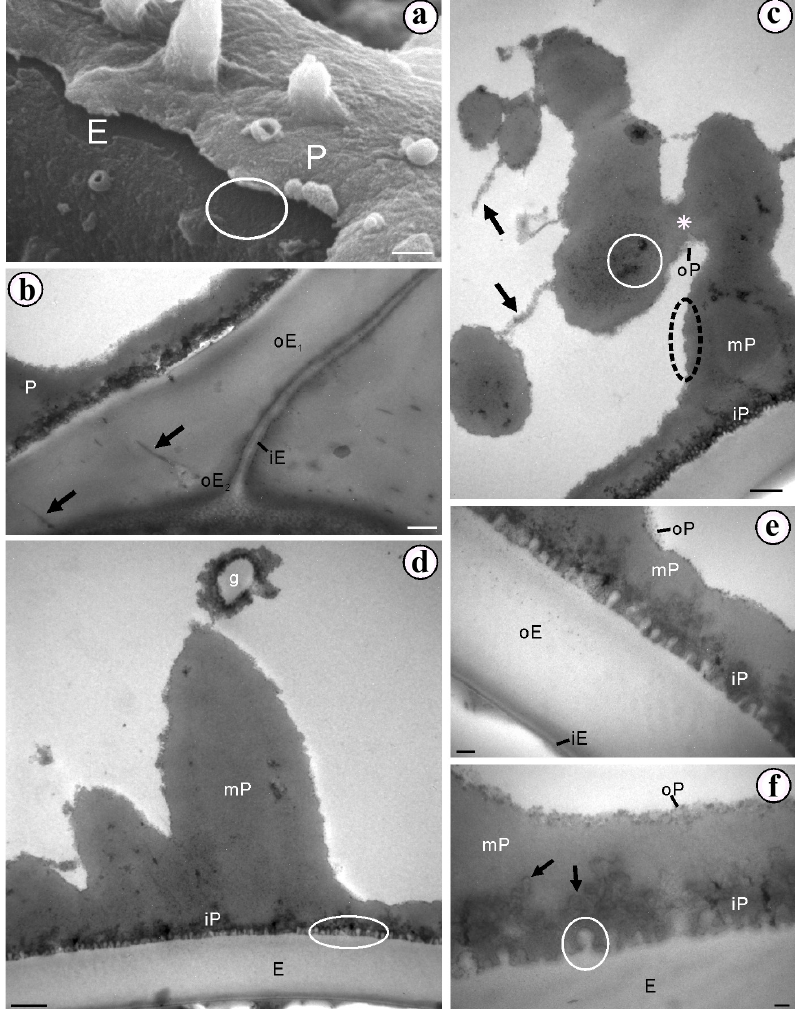
Figure 4 - Spores of Blotiella lindeniana with SEM and TEM. Baculate sculpture. a. Fracture of wall surface with SEM. The exospore has a surface micrornamented (circle). P = Perispore. Figs. b-e. Sections through the sporoderm with TEM. b. Section of the apertural fold. The inner exospore (iE) is thin and homogeneous, with lower electron-density. The inner exospore stratum (oE ) has cavities and channels filled with 2 an electron-dense substance, which are connected with the ramified channels (arrows) of outer stratum (oE ). P = Perispore. c. The outer perispore is discontinuous (oP). The 1 medium perispore (mP) is alveolar with cavities filled by electron-dense substance (continuous circle) and constitutes bacula of the sculpture. The bacula have verrucate margin (discontinuous ellipse) and are fused (asterisc). oP threads connect bacula between them (arrows). The inner perispore (iP) is more electron-dense than others layers. d. Globules are observed on the surface of the perispore (g). The margin of exospore is ornamented (ellipse). mP = medium perispore. iP = inner perispore. e. The inner exospore (iE), outer exospore (oE), inner perispore (iP), medium perispore (mP) outer perispore (oP) are observed. f. The inner perispore (iP) is formed by threads arranged in different positions (arrows). Exospore margin has densely arranged pila (circle). E = exospore. oP = outer perispore. Specimen MP 4227. Bars: a = 1 µm; b, c, d = 0.5 µm; e = 100 nm; f = 50